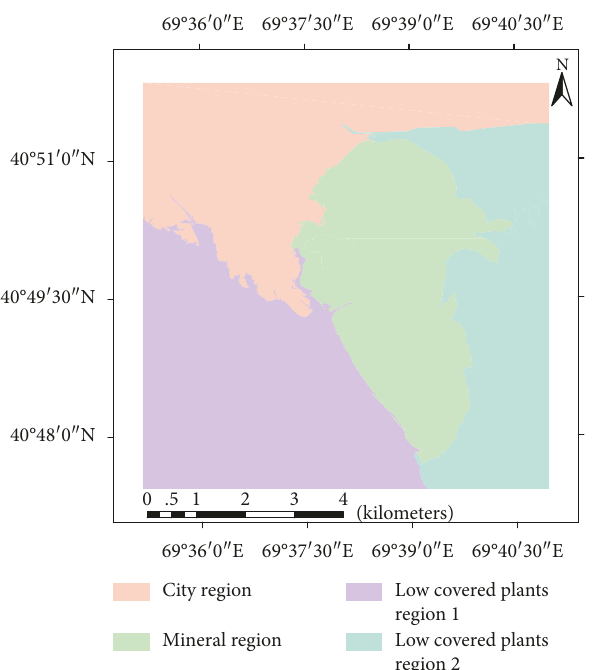
Figure 4: Scene division result of image B.